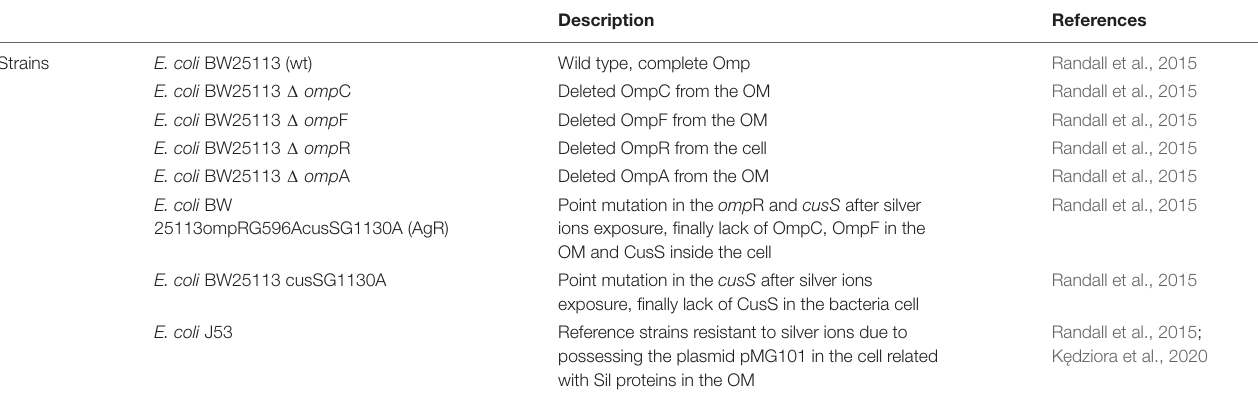
TABLE 1 | Detailed description of bacterial